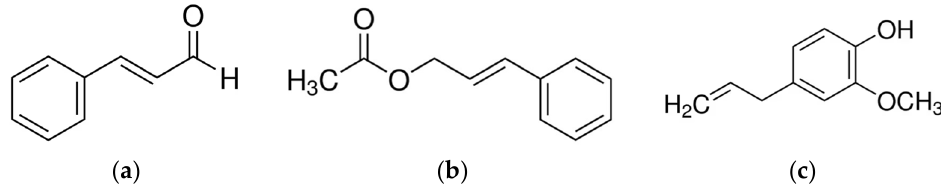
Figure 1. Main components of Cinnamon EOs. ( a ) trans-Cinnamaldehyde; ( b ) Cinnamyl acetate; ( c ) Eugenol.